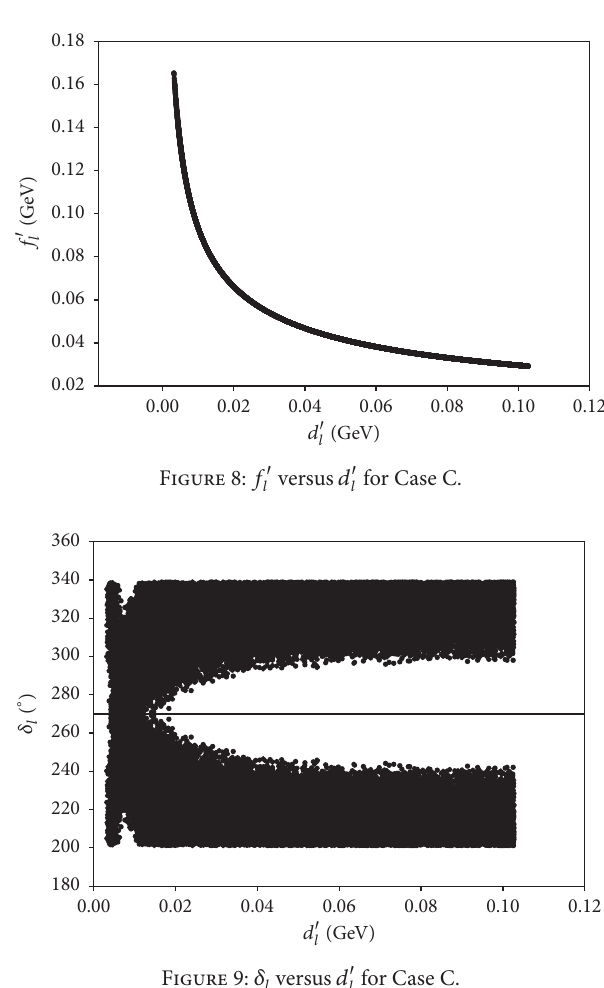
Figure 9: 𝛿 𝑙 versus 𝑑 󸀠 𝑙 for Case C.